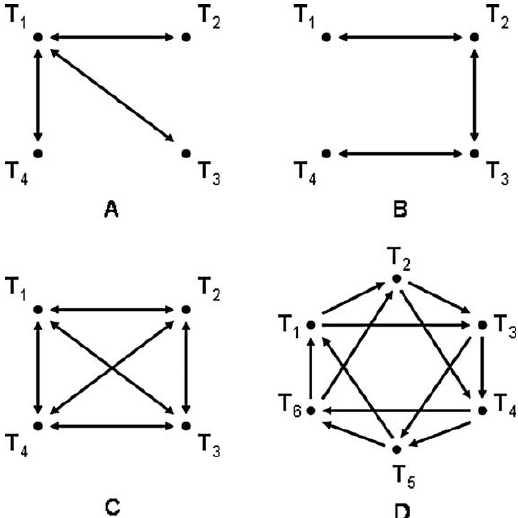
Fig. 1. (A) Optimal design, using 6 arrays, for comparing all time points to T 1 . This design is also a common reference design, with T 1 being the reference. (B) Optimal design, using 6 arrays, for compar- ing gene expression between consecutive time points. (C) Optimal design, using 6 arrays, for comparing both consecutive time points and all time points to T 1 . (D) Example of a loop design using 12 ar- rays to compare 6 time points. An edge or arrow connecting two time points indicates that these two samples are co-hybridized to the same array. The convention that the Cy5 labeled sample is at the head of the arrow and Cy3 at the tail is used. A double arrow indicates a dye